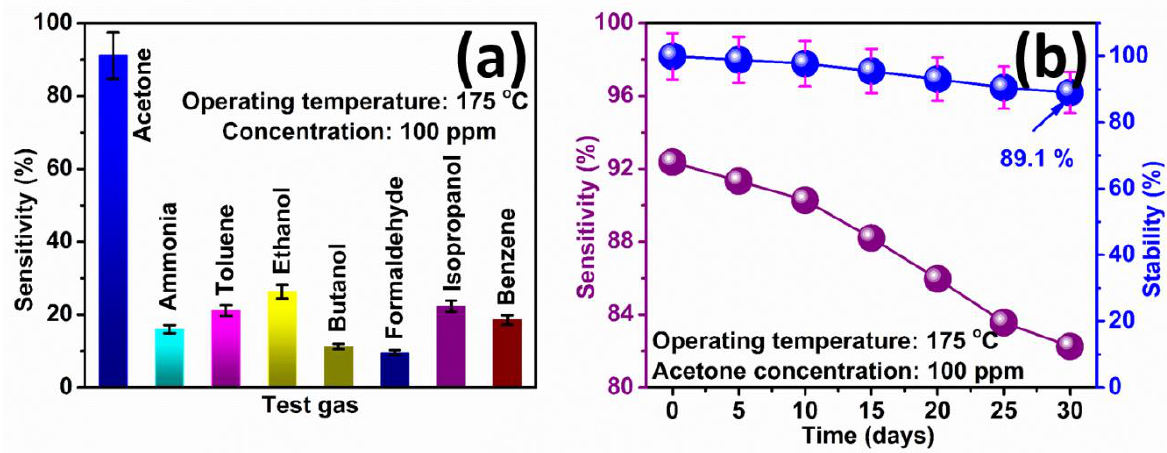
Figure 6. ( a ) Selectivity and ( b ) stability plots of ZnS QDs based acetone